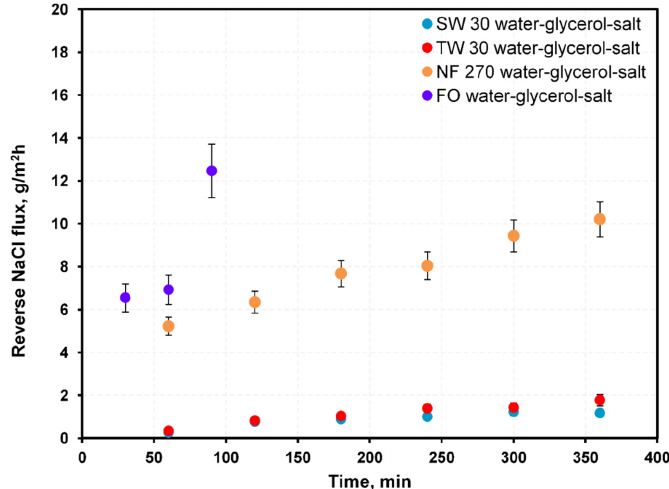
Figure 4. Measured reverse NaCl fluxes through membranes for water–40% glycerol–3% NaCl so-